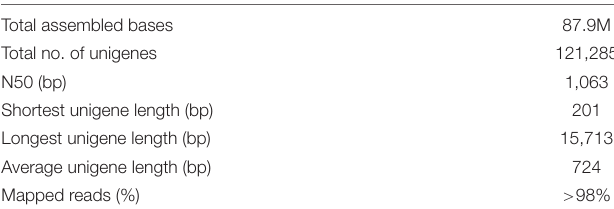
TABLE 2 | Statistics for de novo assembly of the C. camphora